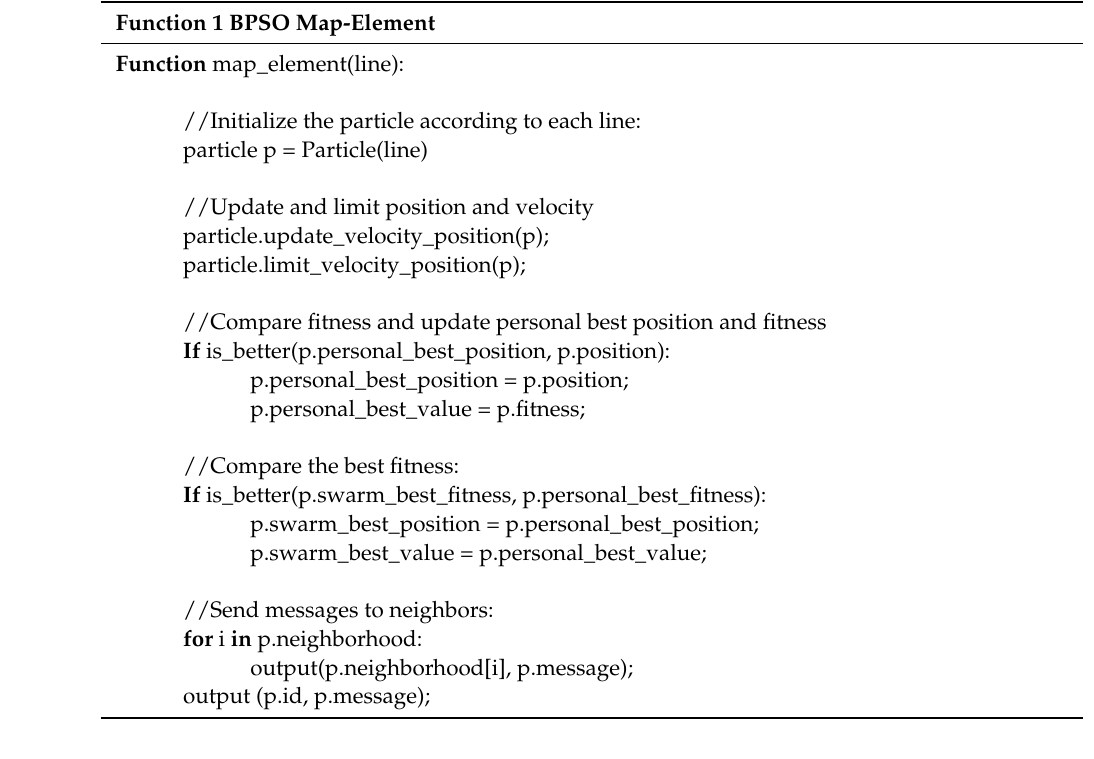
Figure 2. Message of particle 3 (fitness function, sphere function; dimension, 2).